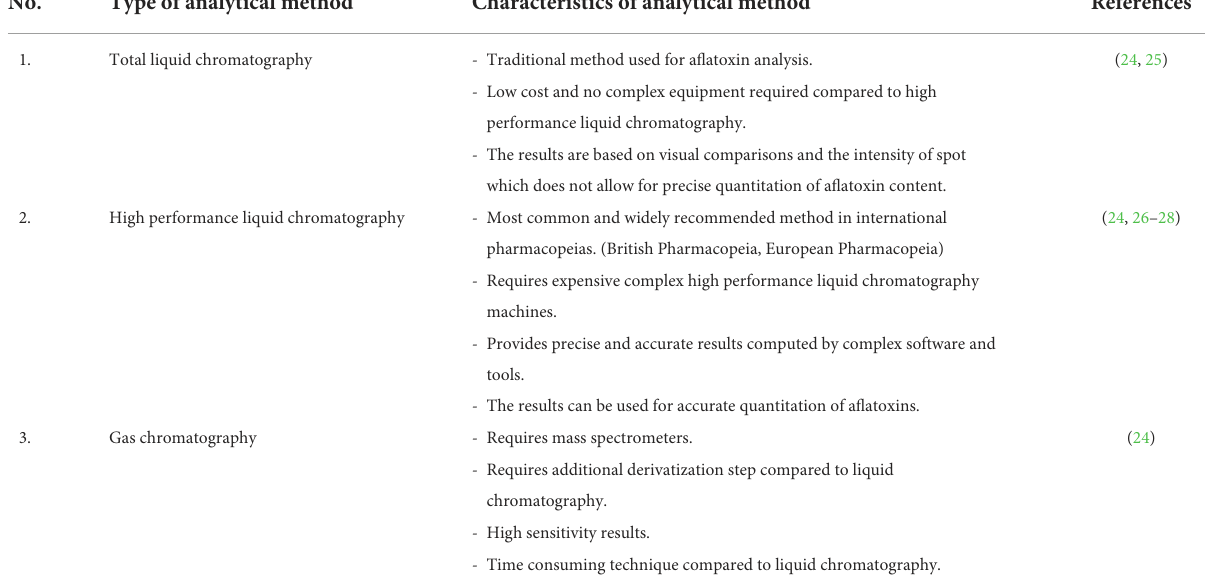
TABLE 2 Analysis of chromatographic techniques used in aflatoxin